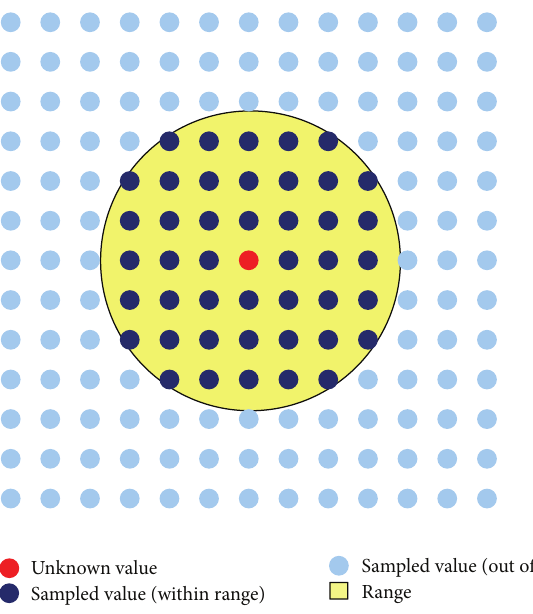
Figure 7: Kriging interpolation schematic